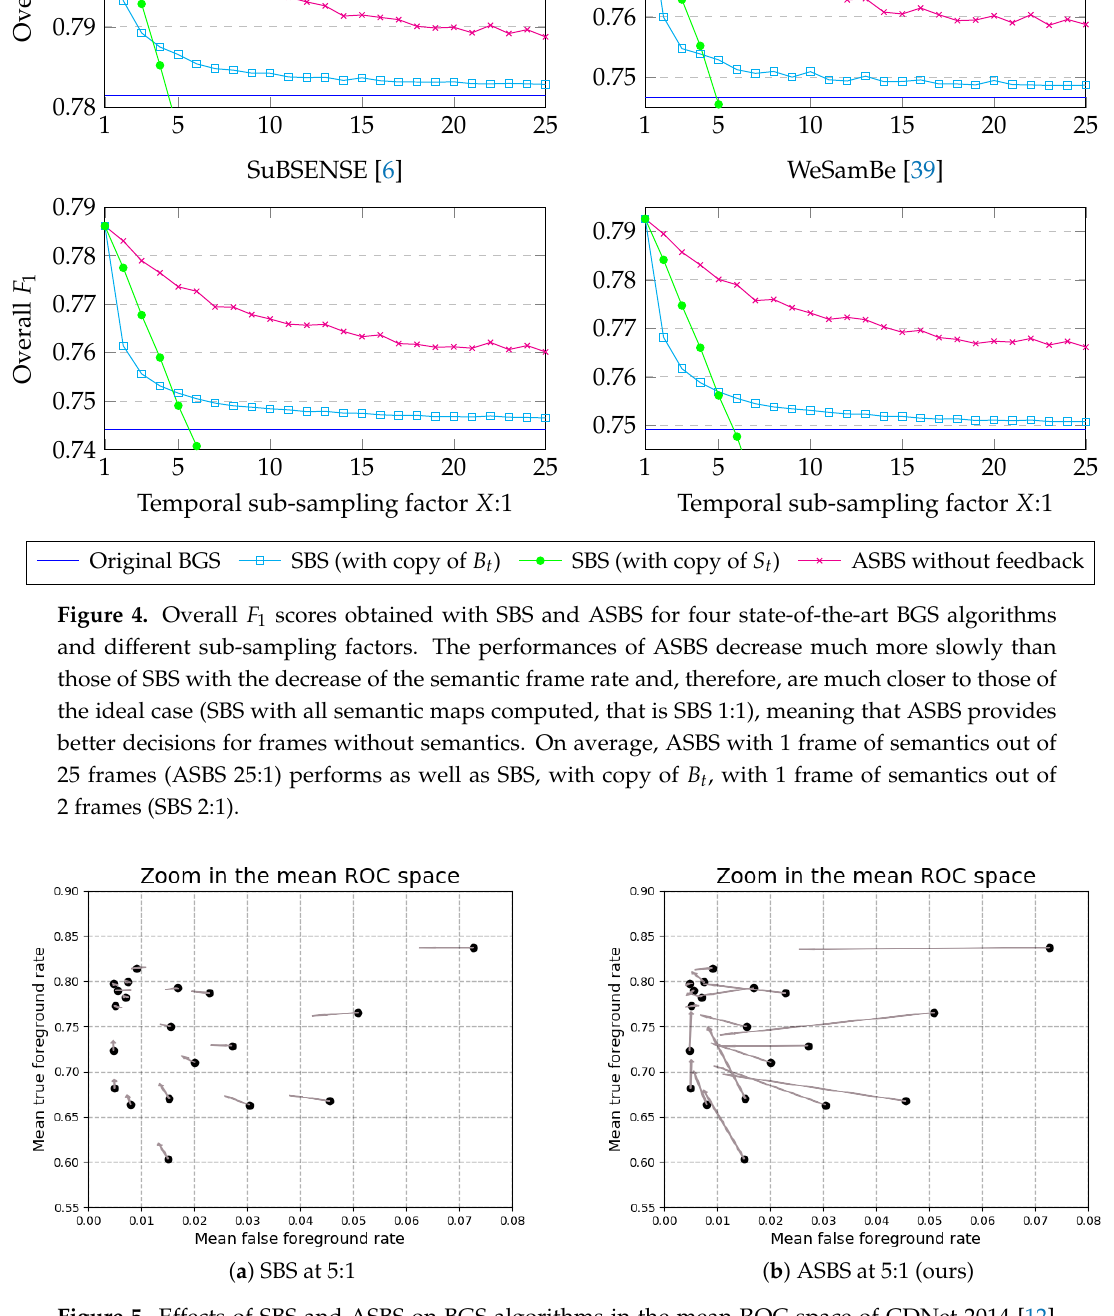
Figure 5. Effects of SBS and ASBS on BGS algorithms in the mean ROC space of CDNet 2014 [12]. Each point represents the performance of a BGS algorithm and the end of the associated arrow indicates the performance after application of the methods for a temporal sub-sampling factor of 5:1. We observe that SBS improves the performances, but only marginally, whereas ASBS moves the performances much closer to the oracle (upper left